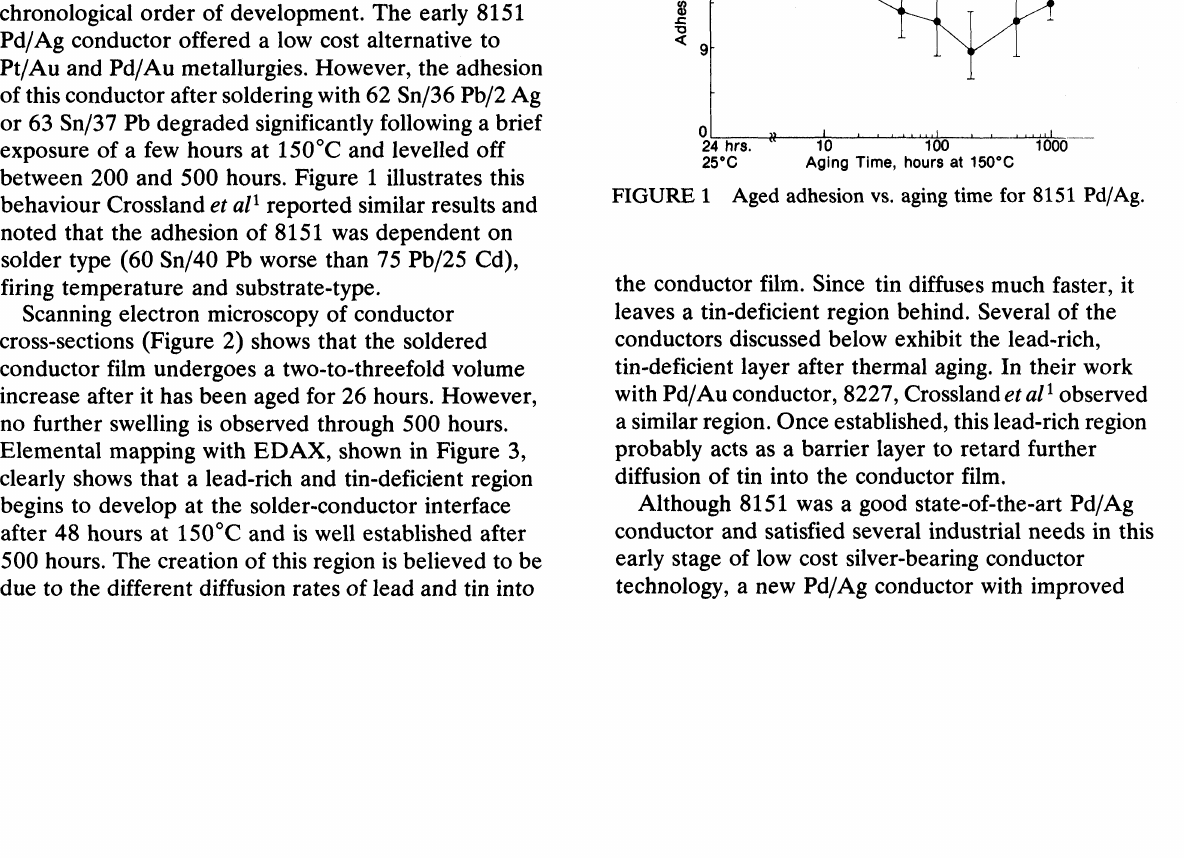
FIGURE 1 Aged adhesion vs. aging time for 8151